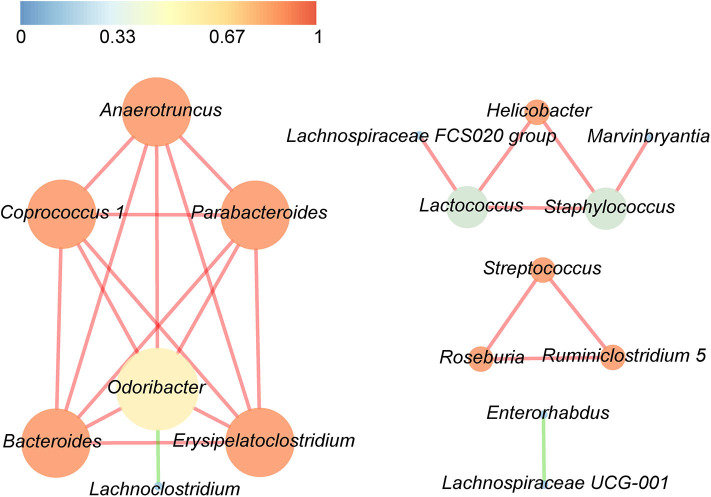
Significant relationships among the top 30 abundant bacterial genera were detected by Pearson correlation coefficient (p < 0.05). The nodes in the interaction network represent the dominant genus, the connection between them shows an association between the two genera, and the red line indicates a positive correlation, whereas the green line indicates a negative correlation. The size of a node is proportionally positive to the degree of the node, and the color of the node is related to the clustering coefficient, that is, the color gradient from dark colors to bright colors corresponds to the value of the aggregation coefficient from low to high.